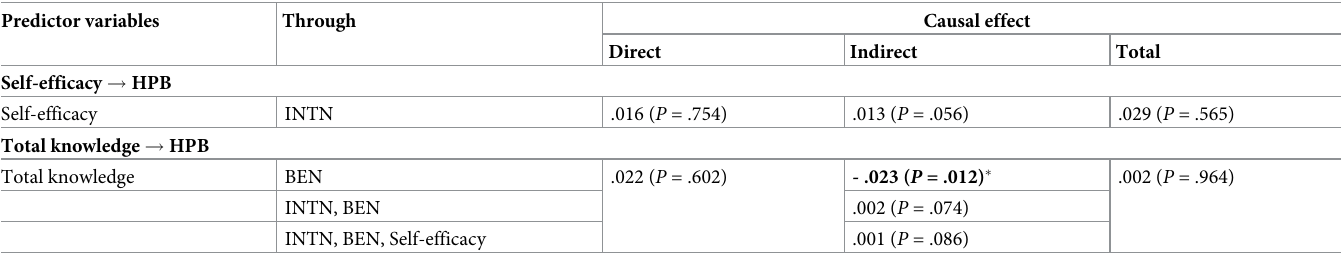
Table 4. Standardised direct, total indirect, and total effect. Predictor